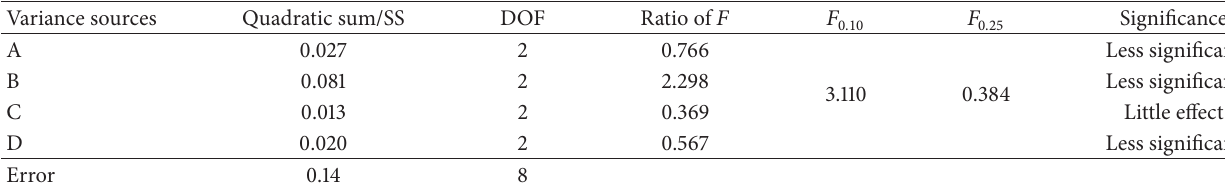
Table 3: Significance analysis ( 𝐹 ) of orthogonal